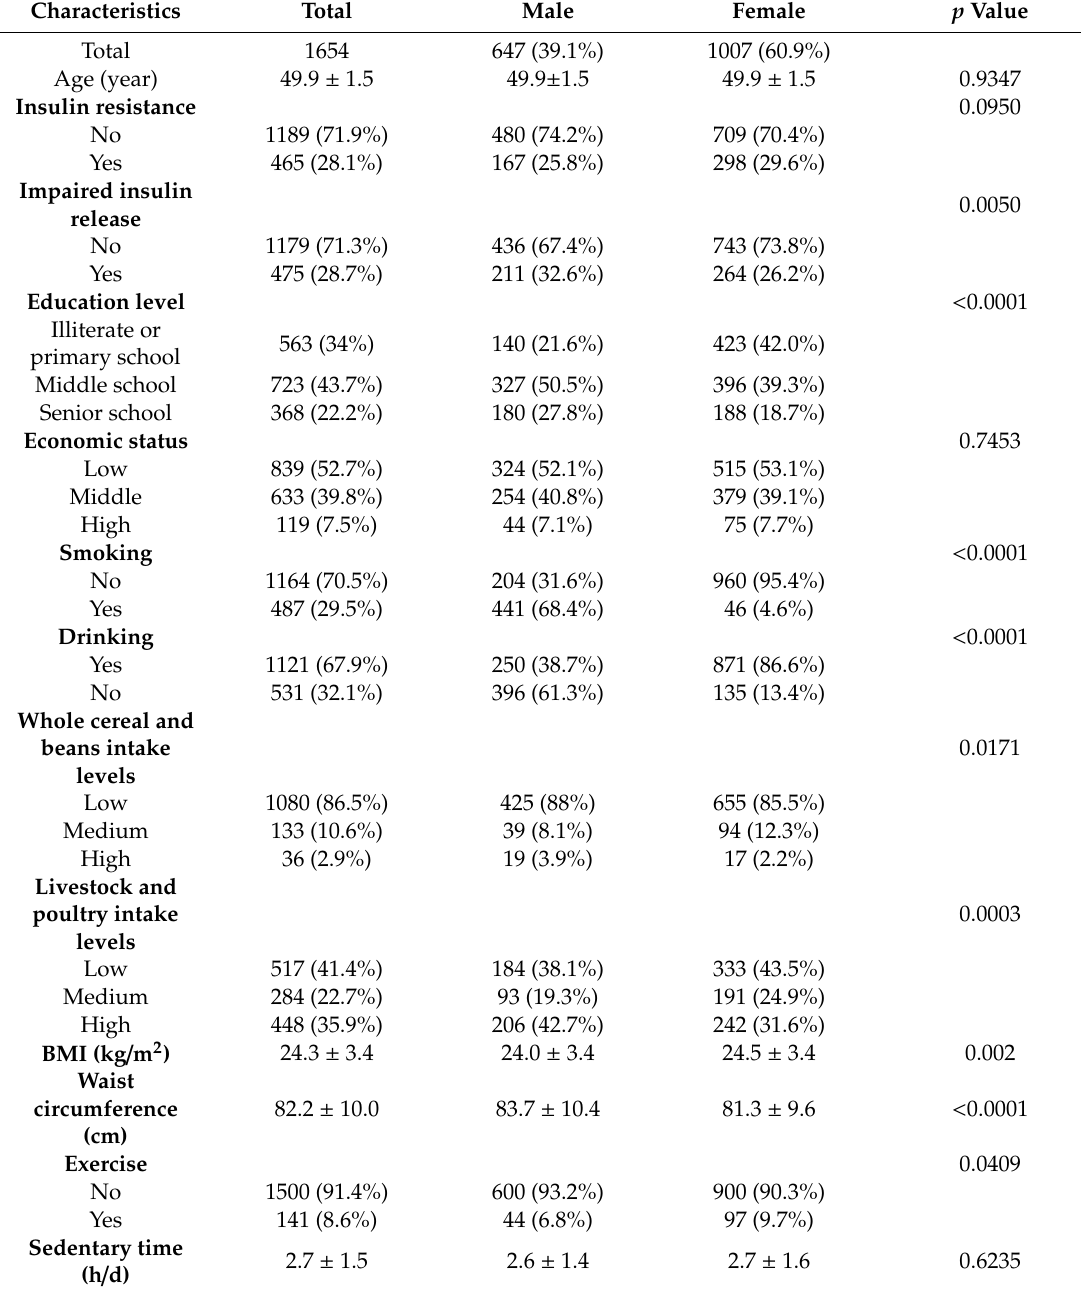
Table 1. Basic characteristics of 1654